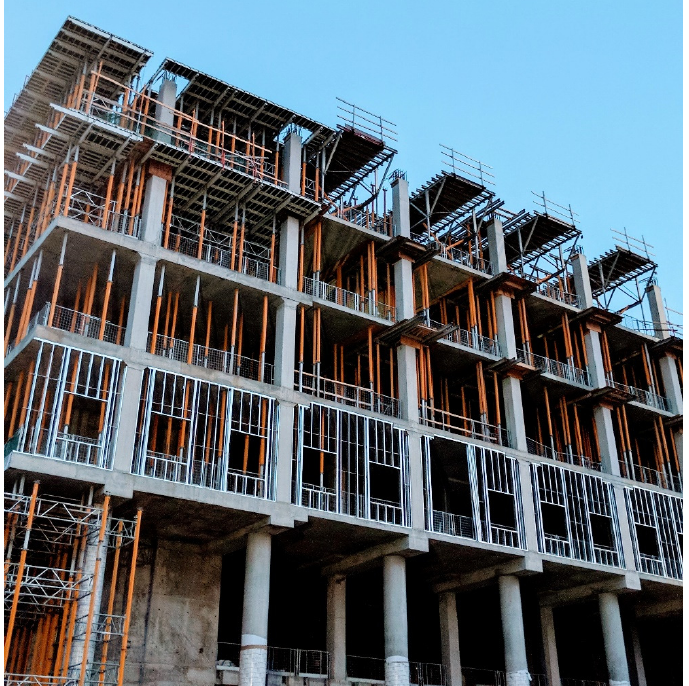
Figure 9. Shoring of the newly cast concrete floors before pouring the next upper floor of a building; guardrails were also used for protection of workers (adapted and used with permission from Olubode